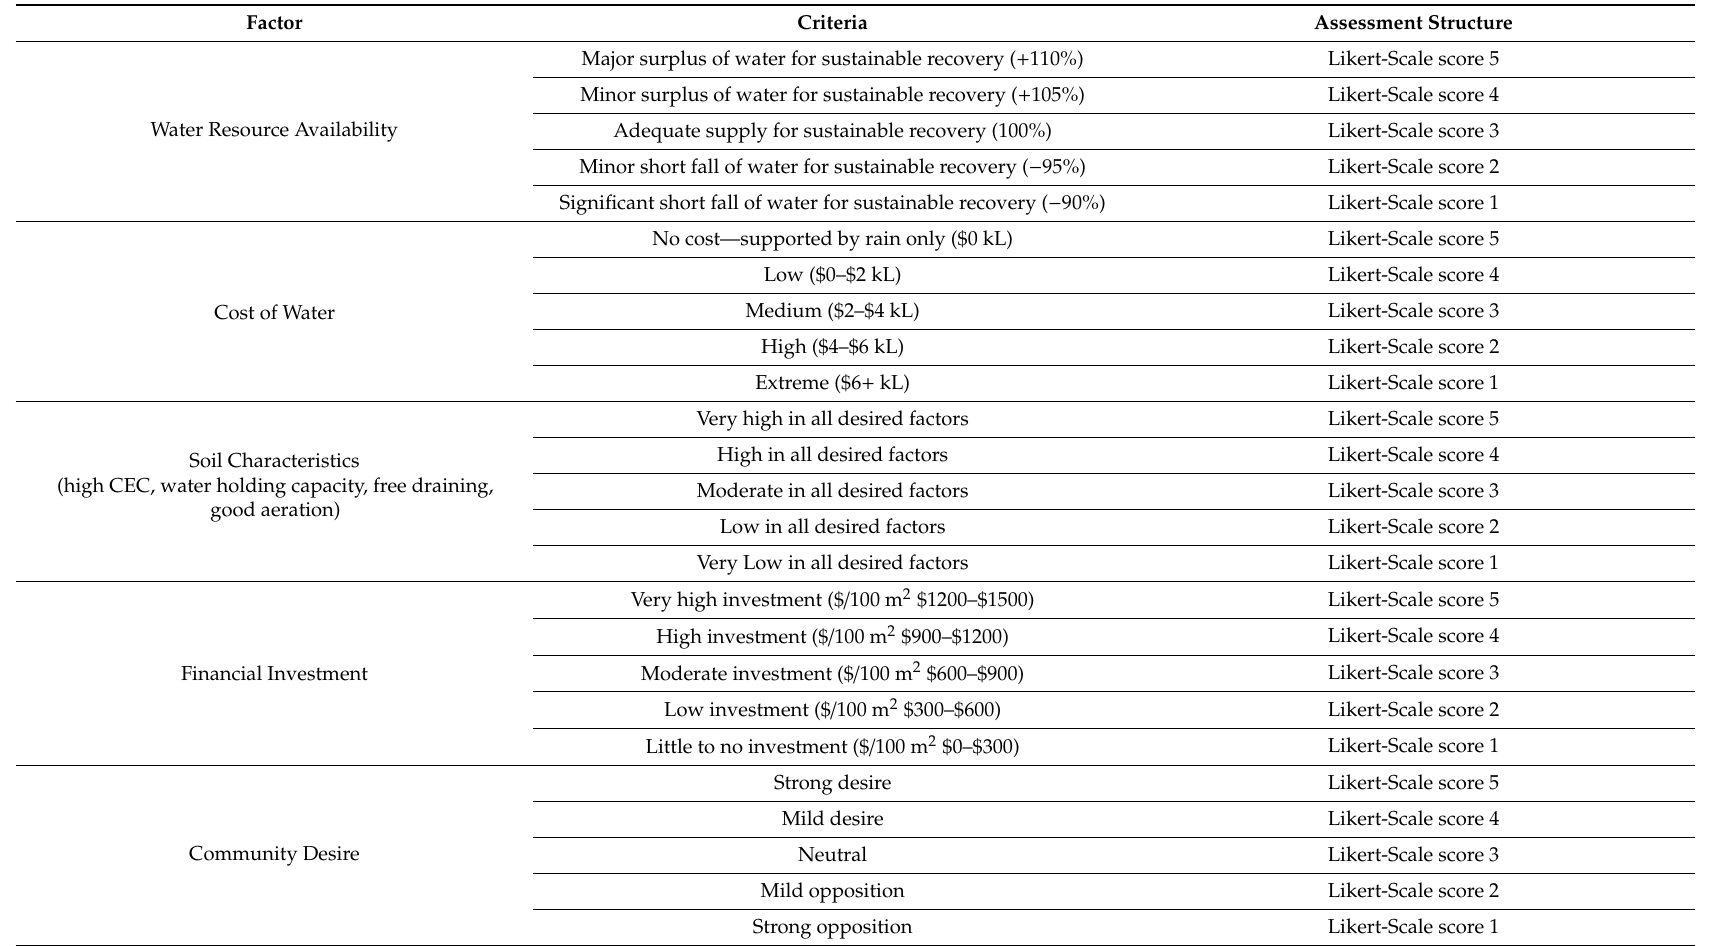
Table A1. Finer detail on criteria assessment